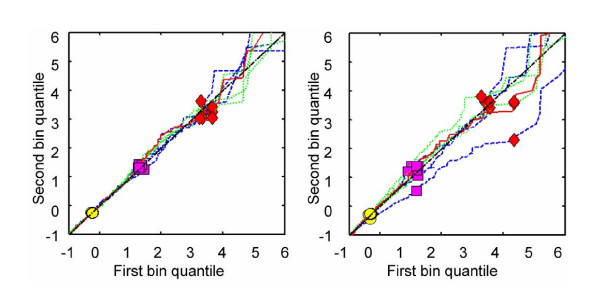
QQ plots of rRD. A – Percentiles of zRD distribution in one bin were plotted against corresponding percentiles of another bin. A bin is the set of all genes having a rank in Wt-t0a that falls between two successive decimal values (e.g. between 30 and 40). Blue dashed, green dotted and red continuous lines indicate, respectively, QQ-plots between contiguous bins, between bins three bins apart, and between the first and the last bin. 50th, 90th and 99th percentiles are marked, respectively, by a yellow circle, a magenta square, and a red diamond, B – QQ plot of zFC.